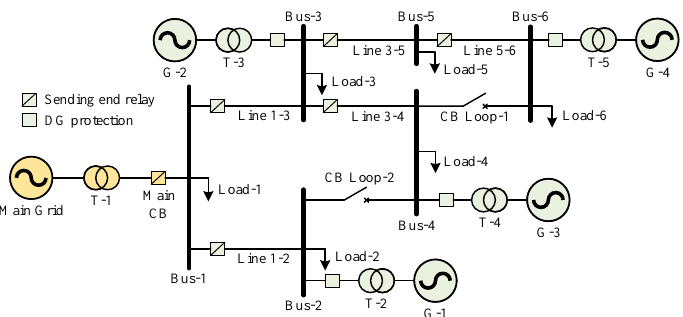
Figure 2. The International Electrotechnical Commission (IEC) standard microgrid system. CB, circuit